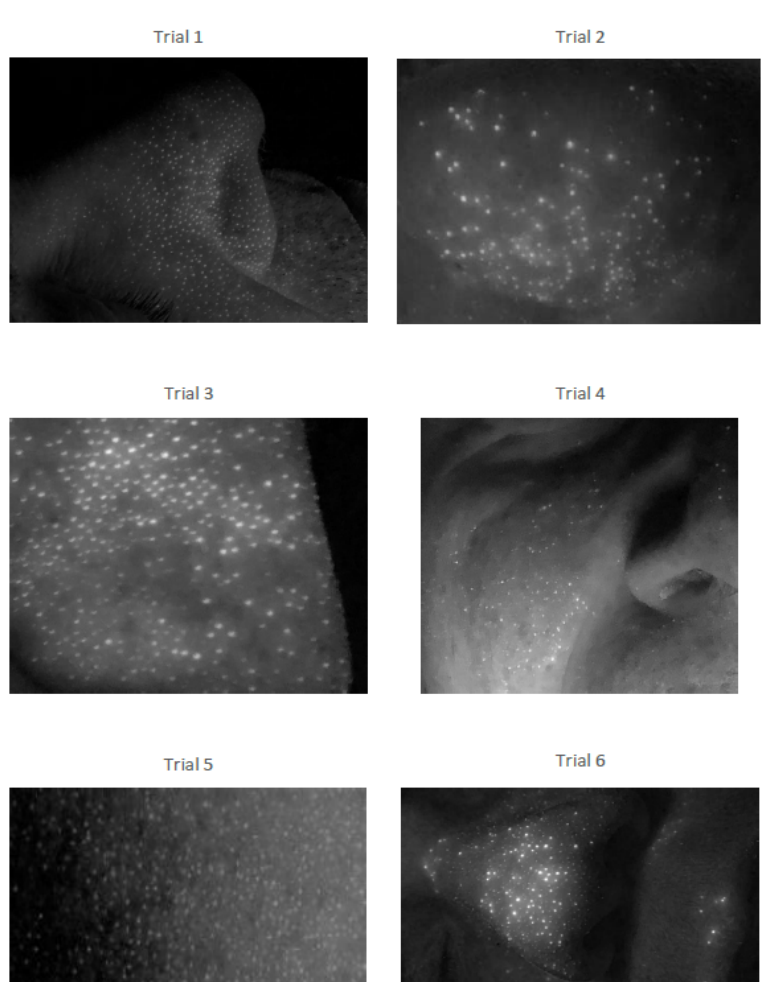
Figure 5. Image of detection of infectious presence of Propionibacterium Acnes for 6 patients.